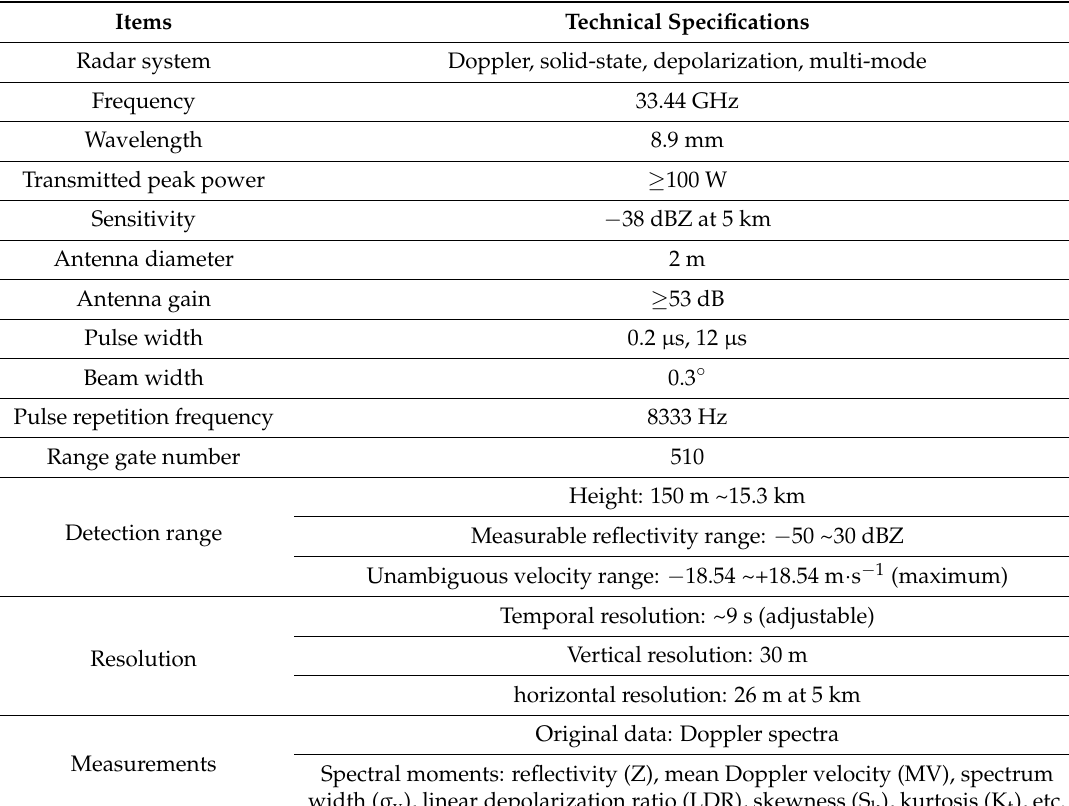
Table 1. Major technical and operational parameters of the Third Tibetan Plateau Meteorological Science Experiment (TIPEX-III) cloud radar.